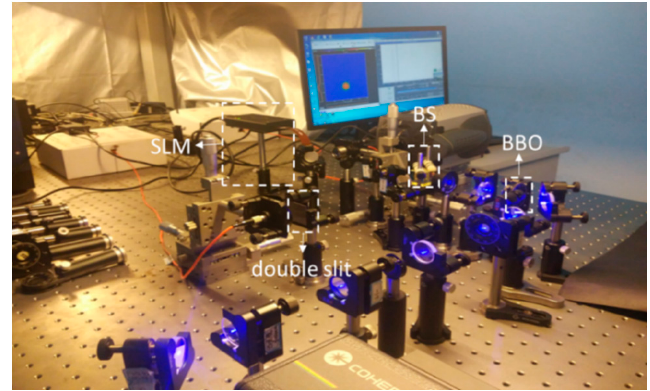
Figure 5. Experimental platform of our quantum GI, where random patterns are placed on the SLM, and the target is a double-slit.